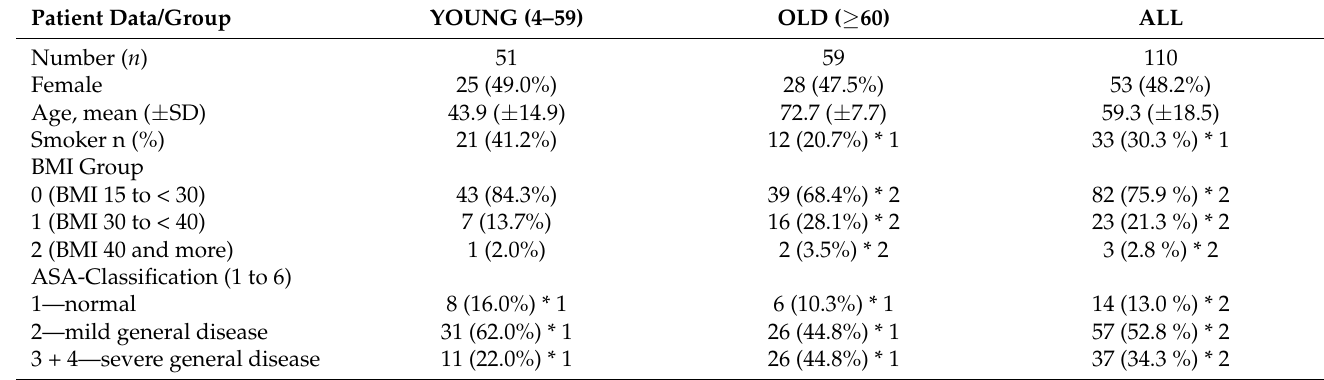
Table 1. Presentation of descriptive statistics of the included patient cohort and the division into the two groups (YOUNG, OLD). * = number of missing records.